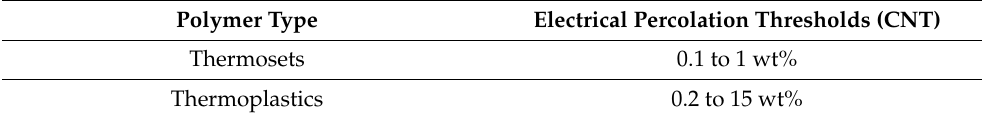
Table 5. Electrical percolation thresholds for CNT-filled thermoplastic and thermoset polymers